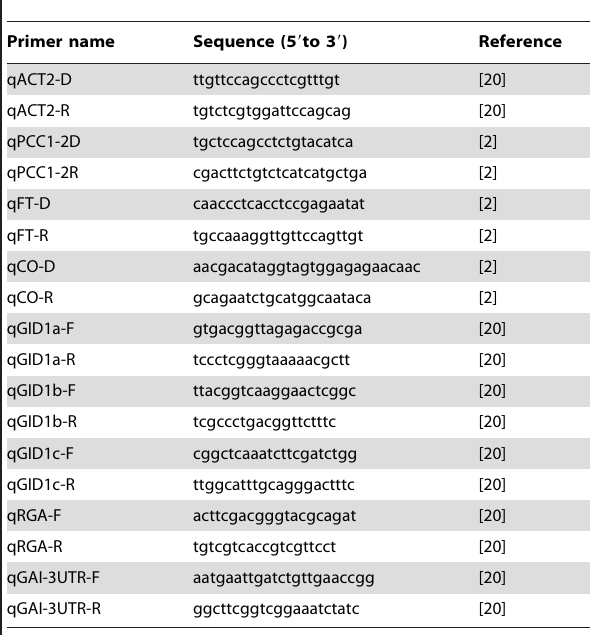
Table 1. Oligonucleotides used for qRT-PCR in this